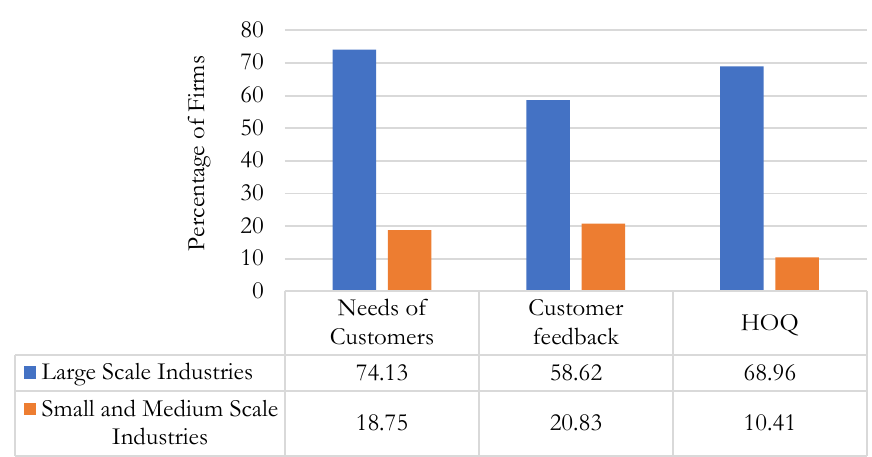
Fig. 7. Comparison of QFD methods between two